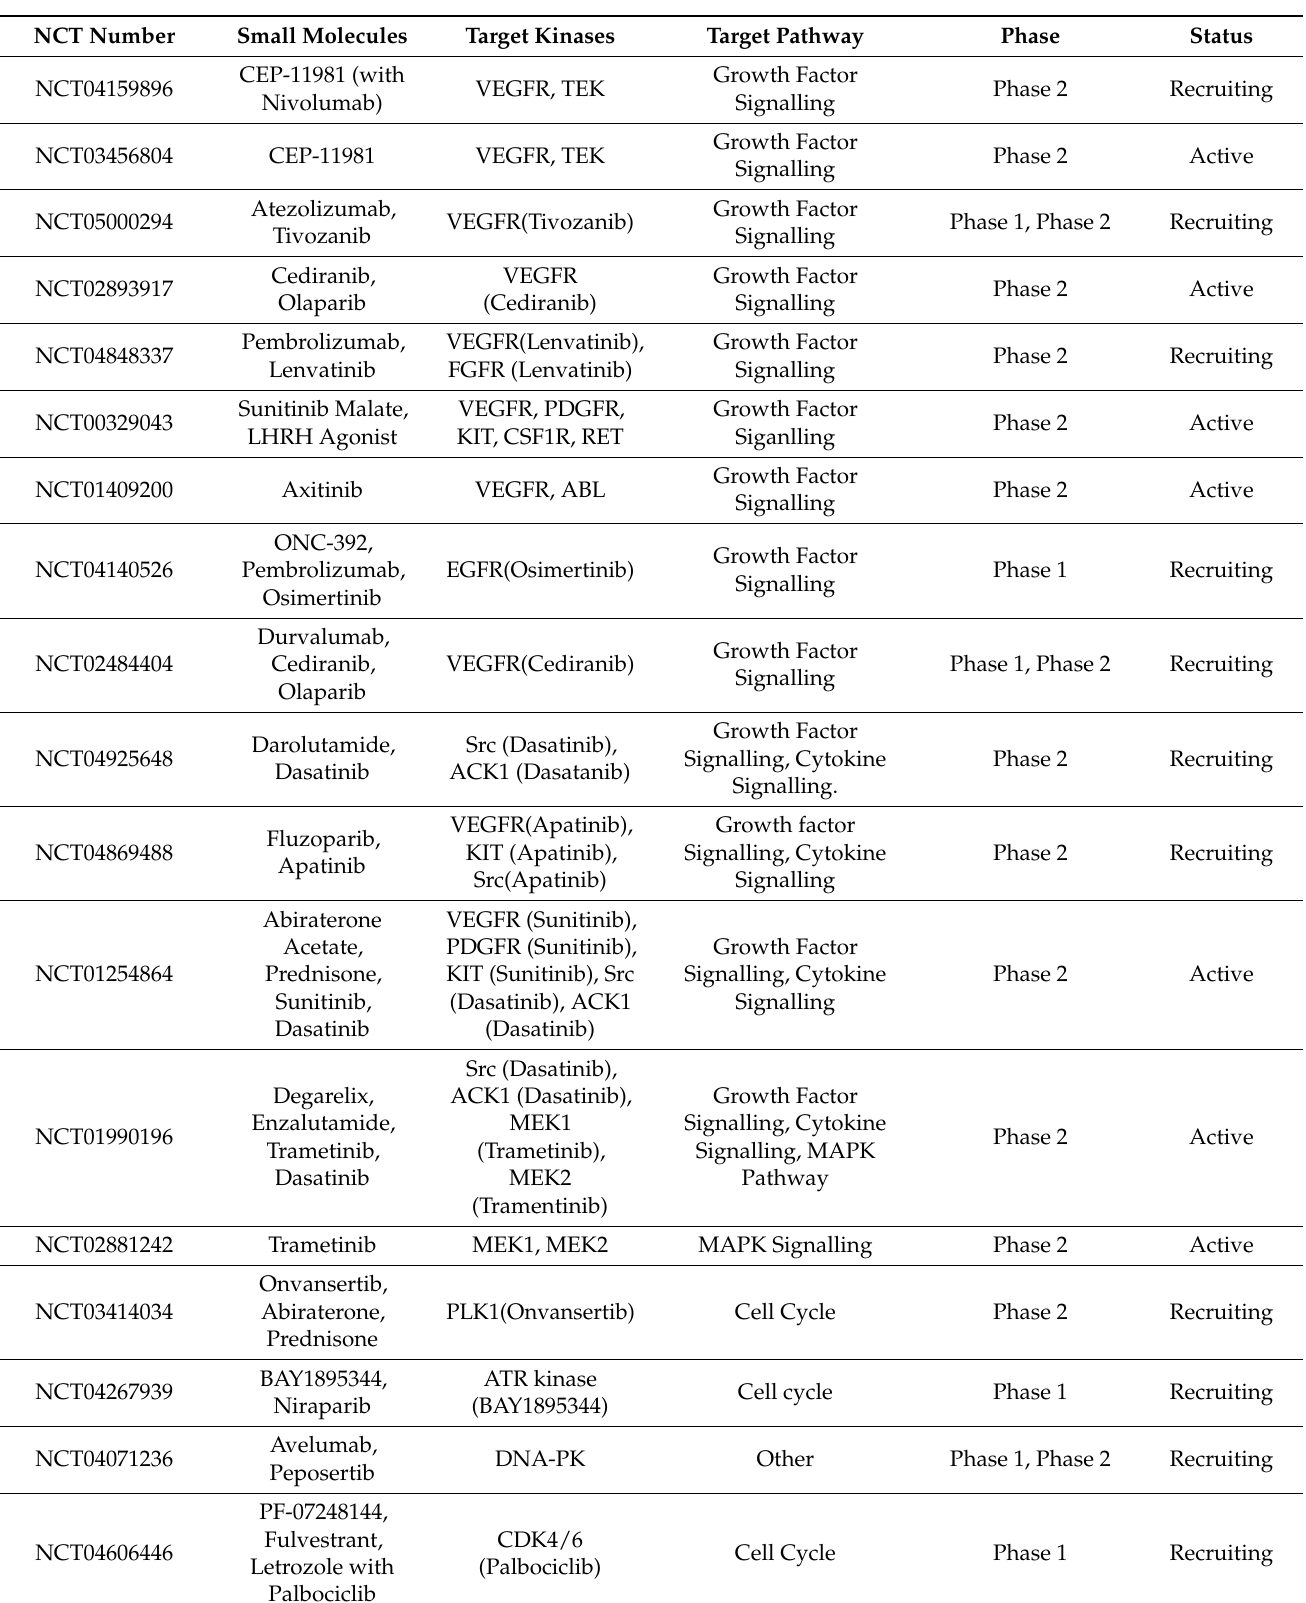
Table 1. Overview of active or recruiting clinical trials of kinase inhibitors for prostate